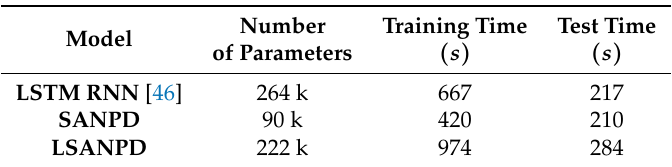
Table 5. Comparison of